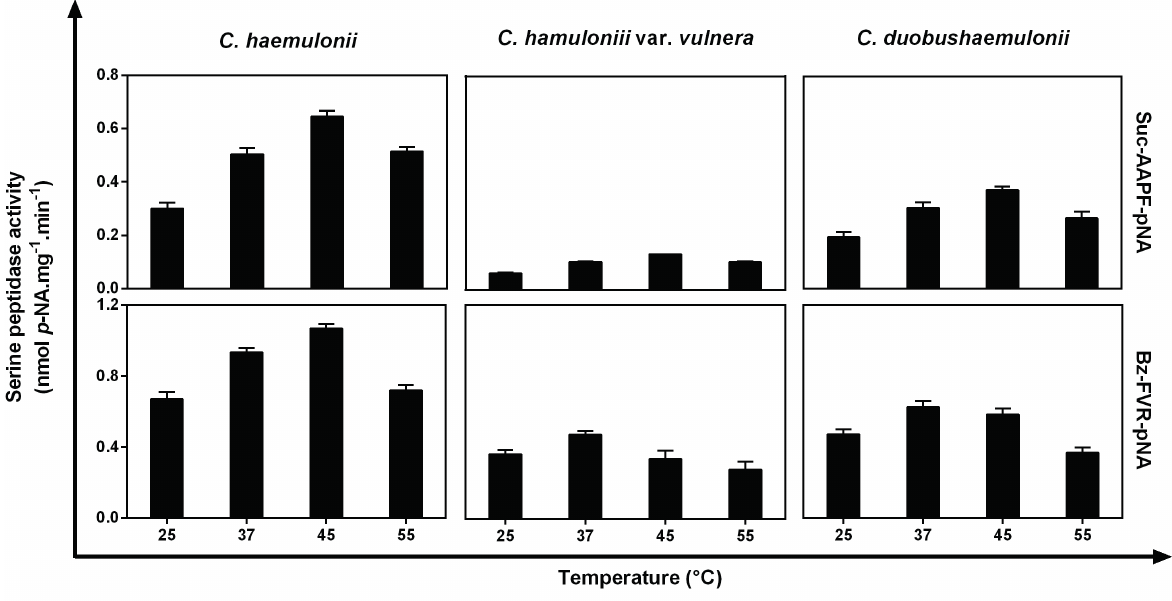
Figure 3 - Effect of temperature on chymotrypsin- and trypsin-like activities measured in the culture supernatants of clinical isolates of the C. haemulonii complex. the serine peptidase activities were evaluated by spectrophotometry for 60 min at 25, 37, 45 and 55°C. two substrates were used: N -succinyl-Ala-Ala-Pro-Phe- p Na for chymotrypsin and N -benzoyl-Phe-Val-Arg- p Na for trypsin, at pH 9.0. the bars represent the mean ± SD from at least three independent